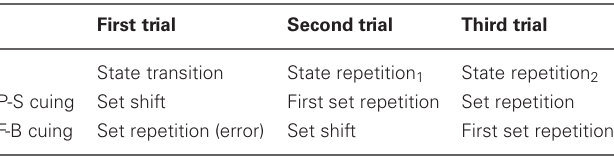
Table 2 | Task switching under certainty/uncertainty across the initial three trials of task